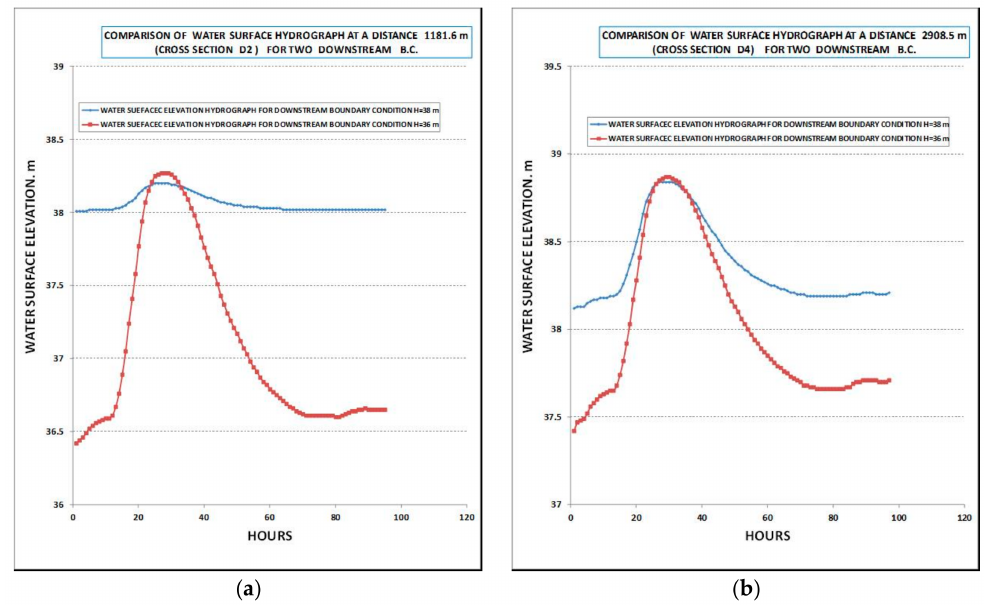
Figure 11. Water stage hydrographs for a maximum input discharge of 1000 m 3 /s, for two different downstream boundary conditions with water elevation of H = 36 m and H = 38 m: ( a ) At a section of a distance 1181 m; ( b ) At a section of a distance 2908 m. Distances are measured from the Arda–Evros confluence.